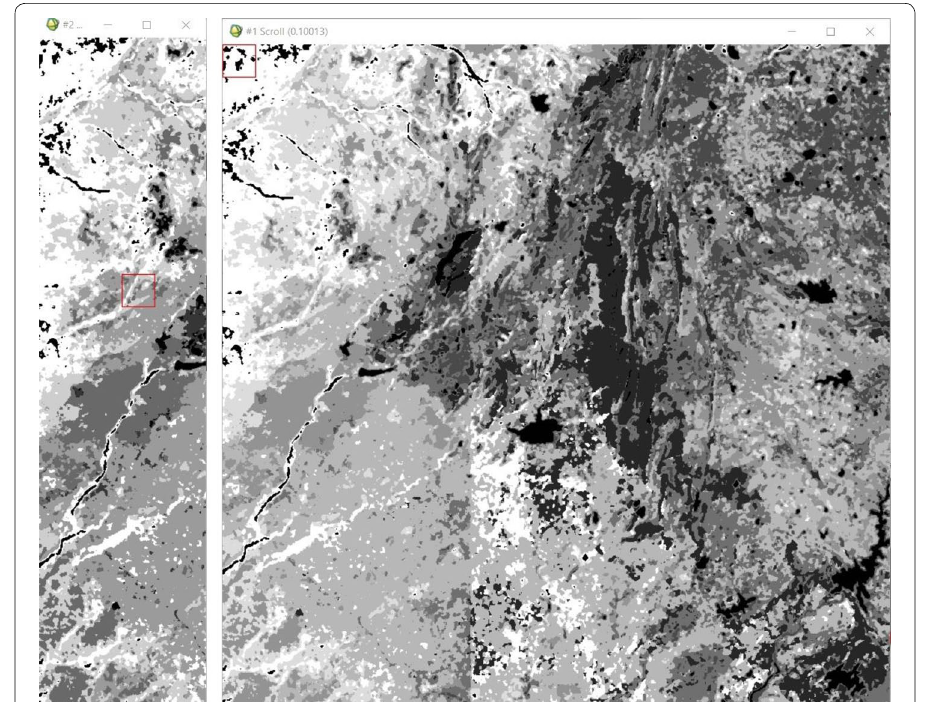
Fig. 13 Vertical splitting of the image in the middle